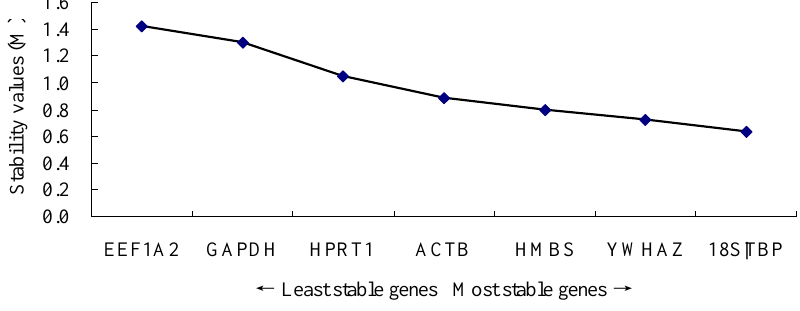
Figure 1. pGene expression stability of candidate reference genes. Gene expression stability of candidate reference genes in goat tissues analyzed by the geNorm program which proceeds to the stepwise exclusion of the genes whose relative expression levels are more variable among tissue samples. Threshold for eliminating a gene as unstable was M  1.5. Lower values of M correspond to the most stable genes, hence the most suitable for normalization.